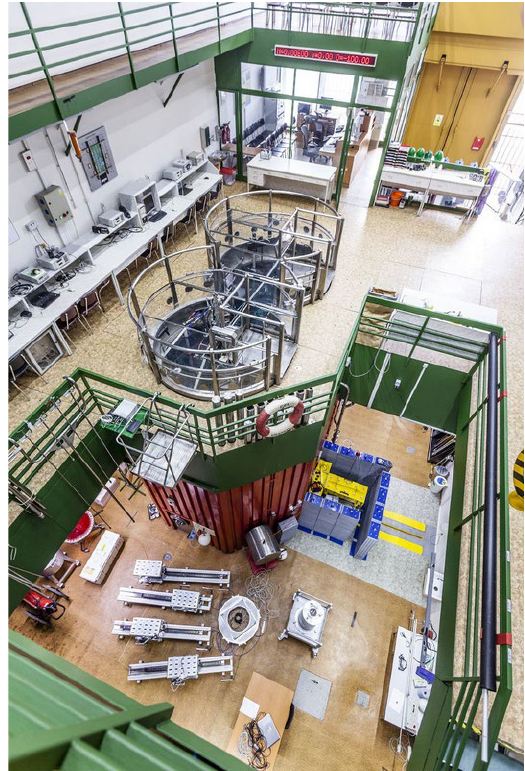
Fig. 3 . Training reactor VR-1, CTU,